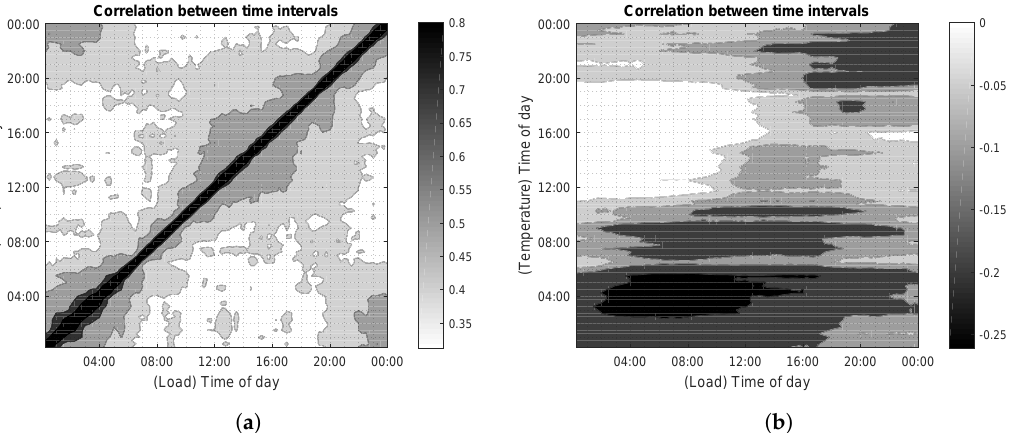
Figure 12. Correlation of power consumption at different time intervals, with darker shading indicating a larger magnitude of the correlation factor. ( a ) Autocorrelation of electric load and ( b ) correlation of load with